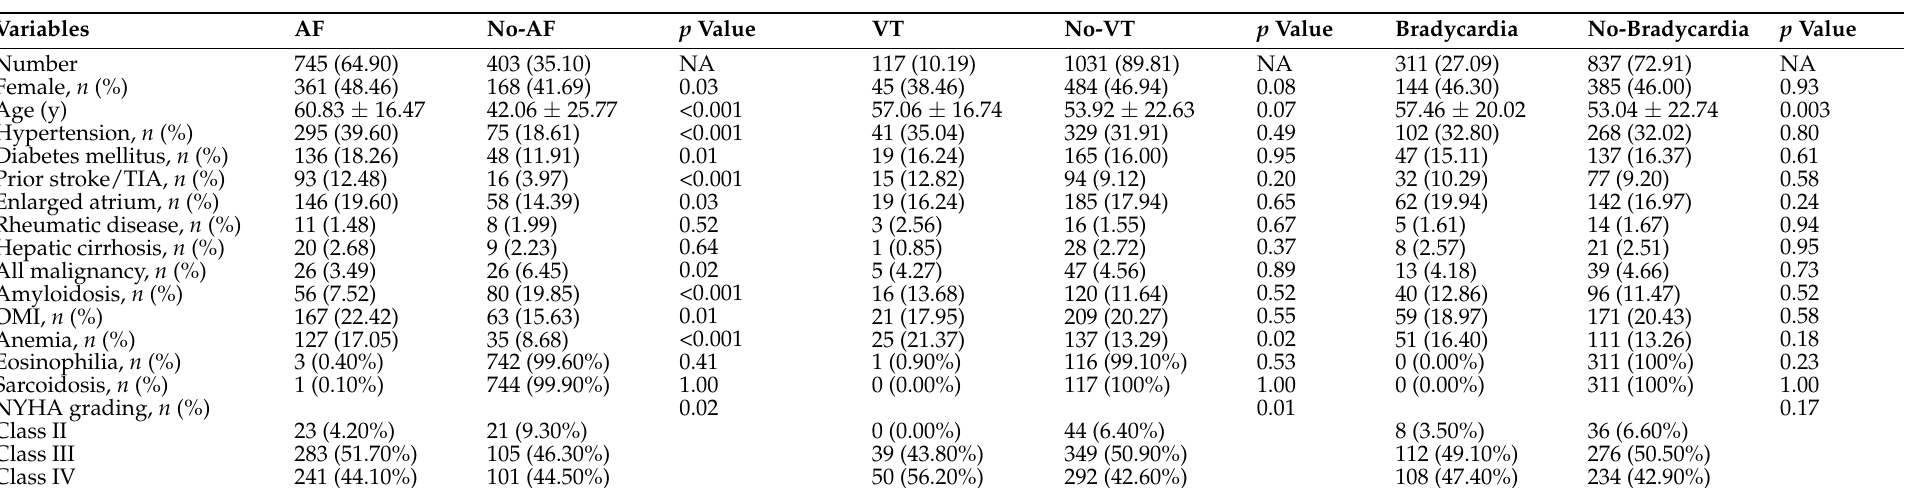
Table 1. Baseline characteristics of the included